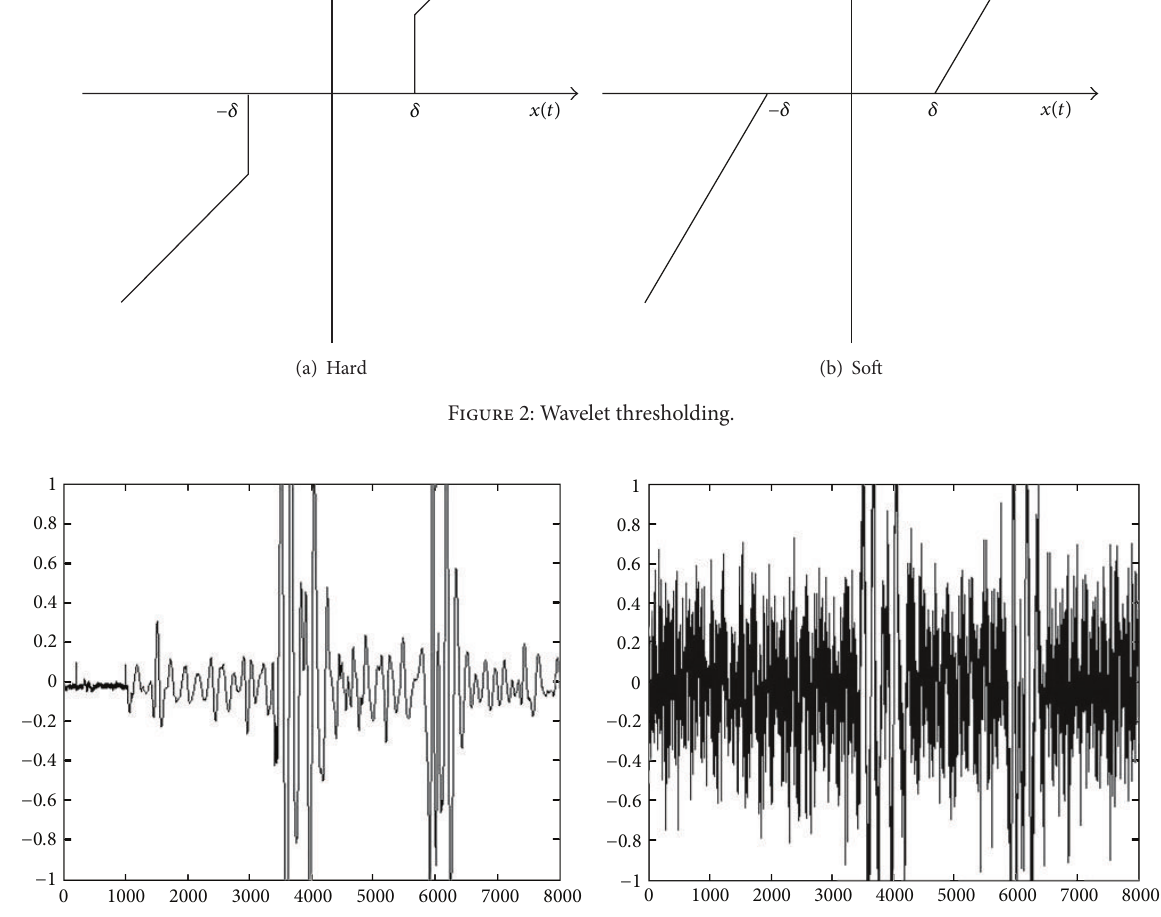
Figure 3: Waveform of (a) reference fPCG signal and (b) test fPCG signal with additive